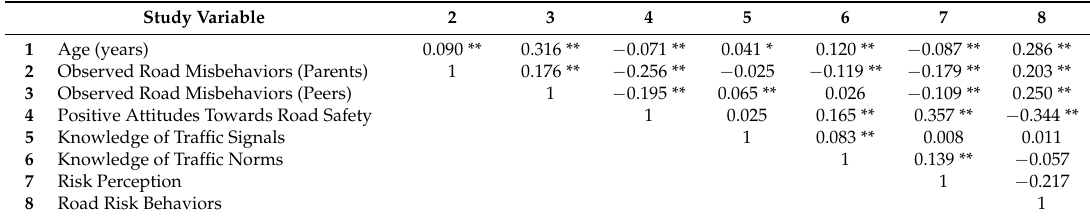
Table 1. Bivariate correlations among study